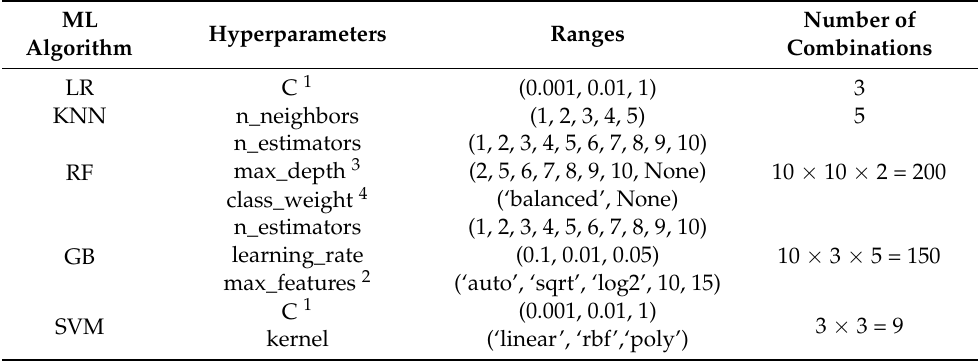
Table 4. Hyper-parameter ranges for the grid search. Summing all the combinations, a total of 367 different models is obtained. ML